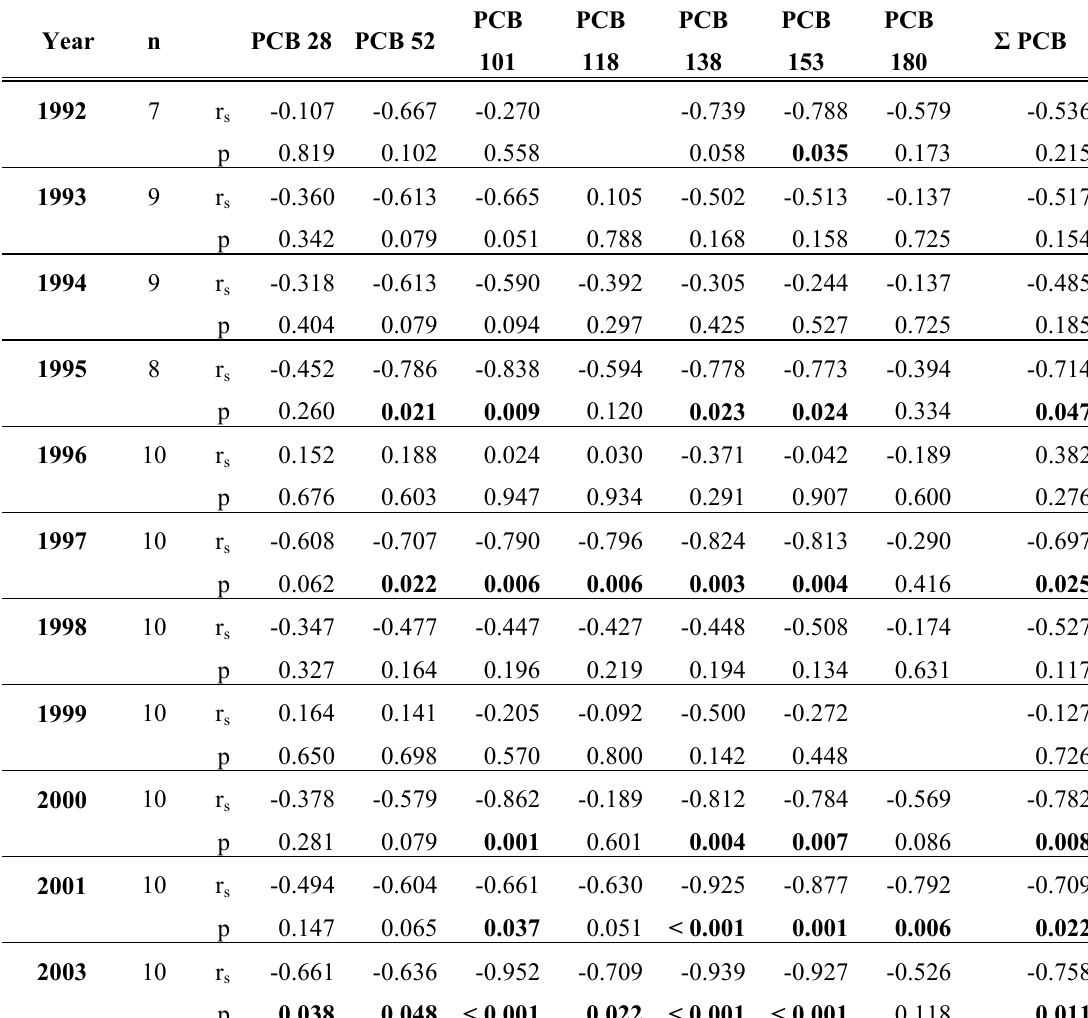
Table 4. Decrease in PCB content with distance from the source of pollution. (r rank correlation of distance from the source of pollution and PCB content, p - significance level). Only sites downstream of the source of pollution (numbers 2-11) were included in the analysis. (n =the number of sites where leeches were